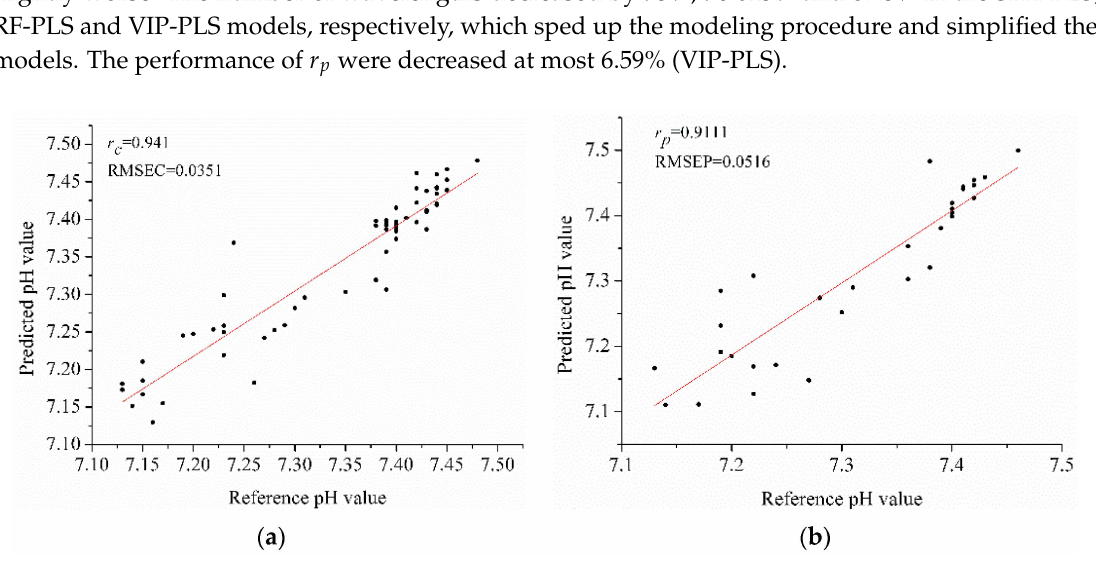
Figure 2. The results of SPA-BPNN model ( a ) calibration set; ( b ) prediction